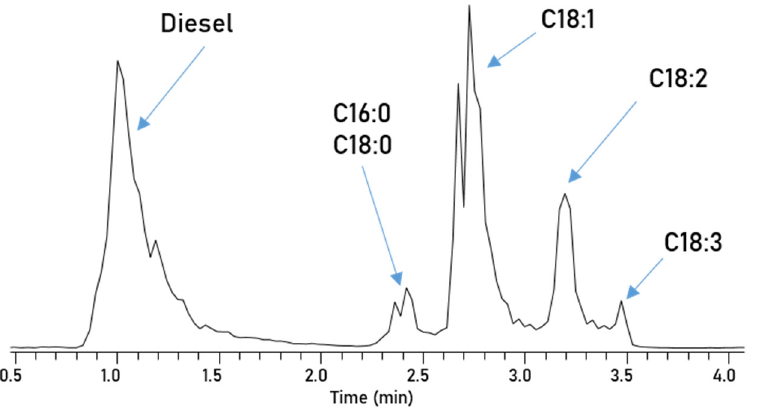
Figure 5. Chromatogram of the blend separated and measured with Method 1.